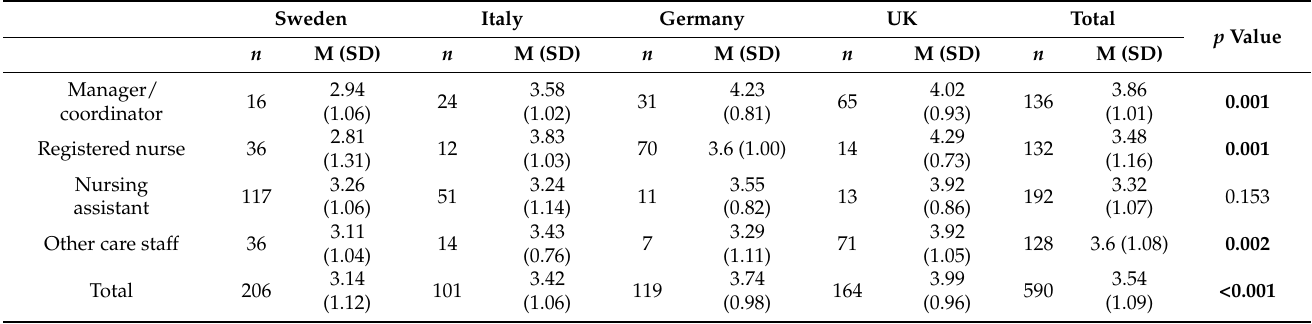
Table 2. Stress and anxiety levels by profession and